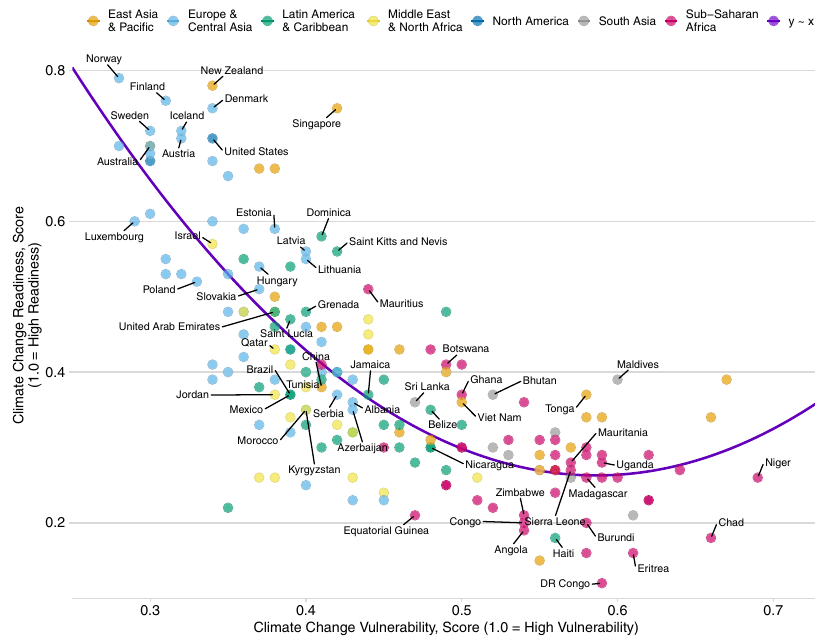
Fig. 8 Relationship between climate change readiness and climate change vulnerability. This plot captures regional convergence (i.e., East Asia & Paci fi